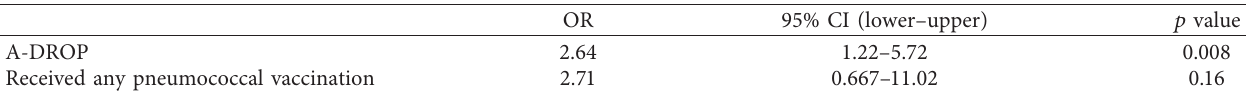
Table 4: Multivariate analysis of risk factors for mortality.